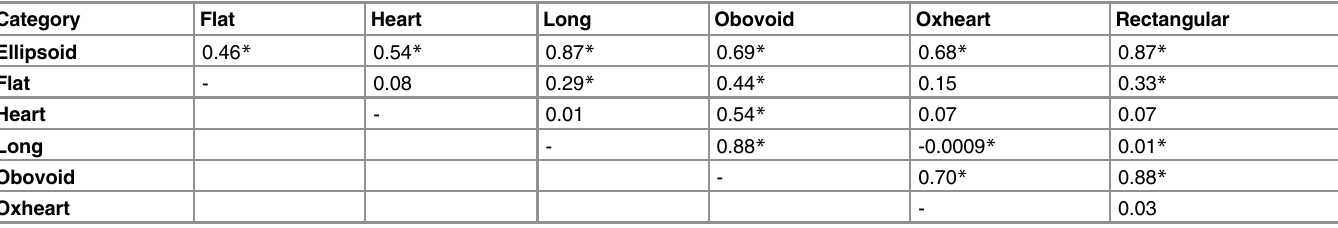
Table 6. Genetic differentiation of pepper lines when grouped by fruit shape categories A .